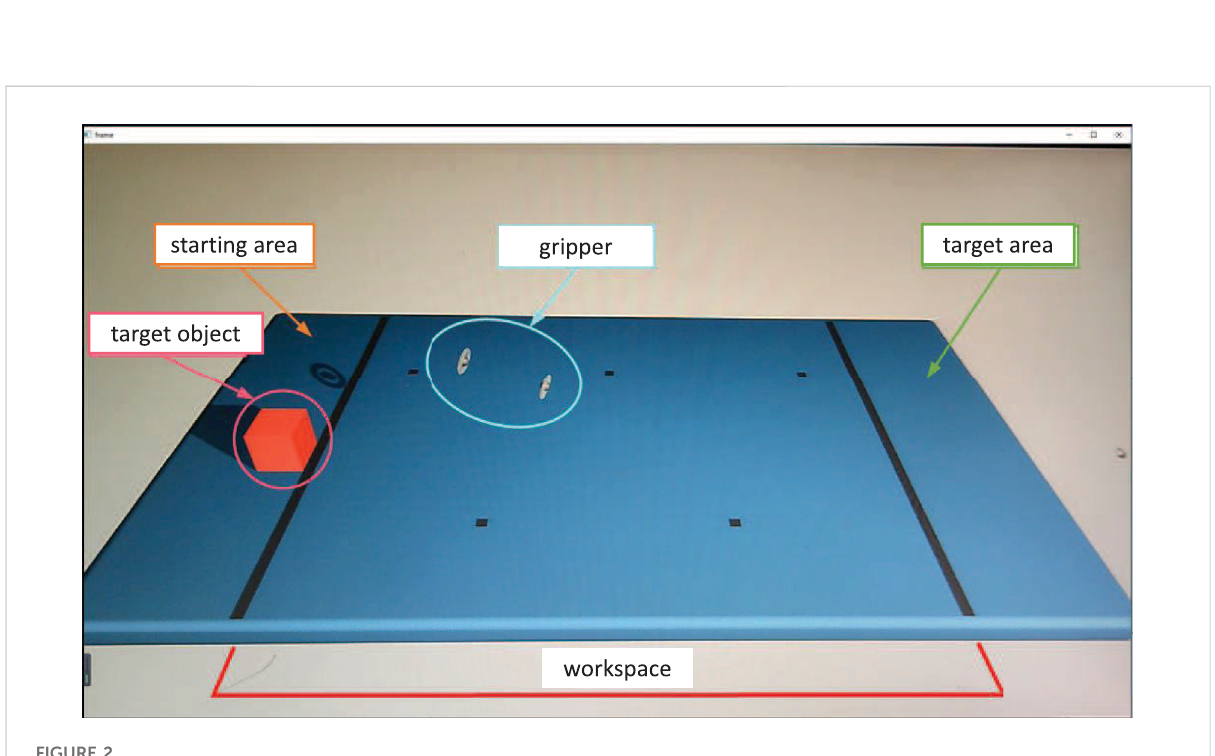
Virtual interactive